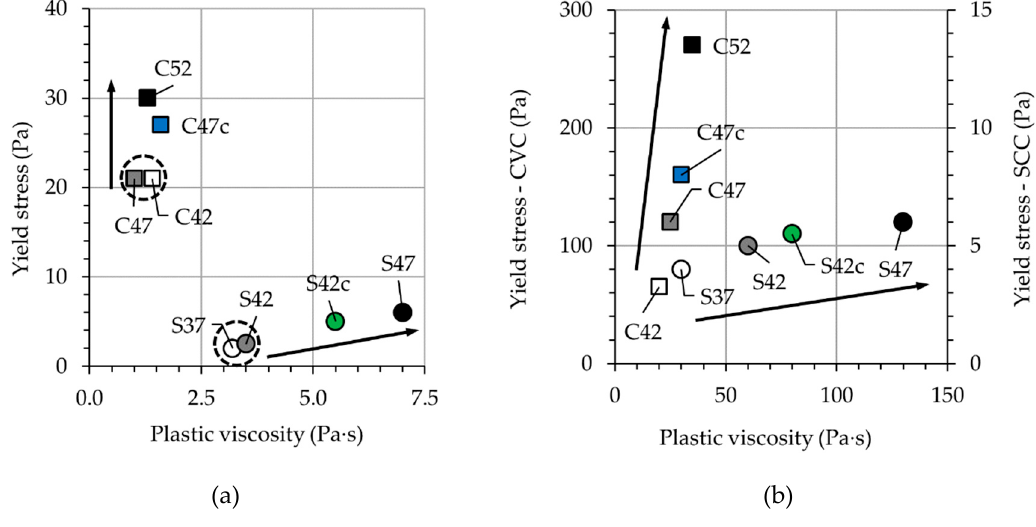
Figure 8. Yield stress and plastic viscosity for ( a ) mortar and ( b ) concrete. Arrows indicate the increase in reduced volume-fraction φ / φ c